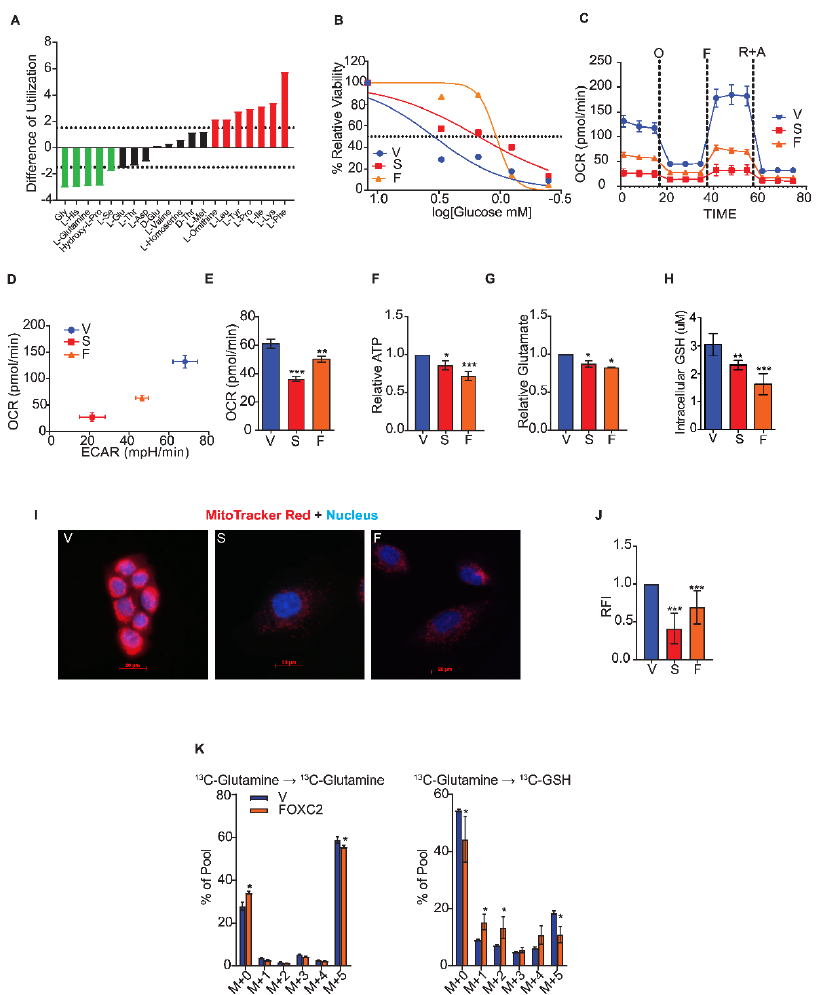
Figure 2. Cells that undergo EMT fail to utilize glutamine. ( A ) The difference in amino acid utilization between HMLER cells that express Snail and control cells that express vector only at 8 hours. Negative values indicate metabolic loss (green). Positive values indicate metabolic gain (red). Dotted lines at -1.5 and 1.5 indicate significance. ( B ) Viability of HMLER cells that express vector only (V), Snail (S), and FOXC2 (F) cells after 24 hours in 0, 0.4, 0.8, 1.5, 3, and 12 mM glucose quantified relative to viability in normal growth media using MTS assay. ( C ) Oxygen consumption of control cells (V, n = 6) and cells that express Snail (S, n = 5) and FOXC2 (F, n = 5) over time (in minutes) after addition of oligomycin (O), FCCP (F), and rotenone plus antimycin (R + A) measured using a Seahorse Analyzer. ( D ) OCR versus ECAR measured using Seahorse Analyzer in control (V, n = 6), Snail-expressing (S, n = 5), and FOXC2-expressing (F, n = 5) HMLER cells. ( E ) Basal respiration rate (pmol/min) of HMLER control cells (V, n = 6) and cells that express Snail (S, n = 5) and FOXC2 (F, n = 5) as measured using a Seahorse XFe96 Analyzer. ( F ) ATP production measured by luminescence in Snail-expressing (S, n = 5) and FOXC2-expressing (F, n = 5) HMLER cells relative to production by control cells (V, n = 5). ( G ) Quantification of relative intracellular glutamate in Snail-expressing (S, n = 3) and FOXC2-expressing (F, n = 3) cells relative to control (V, n = 3) cells. ( H ) Quantification of intracellular GSH in control (V, n = 5), Snail-expressing ( n = 5), and FOXC2-expressing ( n = 5) HMLER cells. ( I ) Representative immunofluorescence images of HMLER control (V), Snail-expressing (S), and FOXC2-expressing (F) cells stained with MitoTracker Red (red) and DAPI (blue). Scale bar: 20 µ m. ( J ) Relative fluorescence intensity (RFI) of MitoTracker staining in Snail-expressing (S, n = 100) and FOXC2-expressing (F, n = 100) HMLER cells versus control cells (V, n = 100) quantified using ImageJ software. ( K ) U 13 C-glutamine flux in FOXC2-expressing ( n = 4) and control (V, n = 4) HMLER cells determined by mass spectrometry. The data are reported as means ± SD; * p ≤ 0.05, ** p ≤ 0.01, *** p ≤ 0.001, NS indicates p >